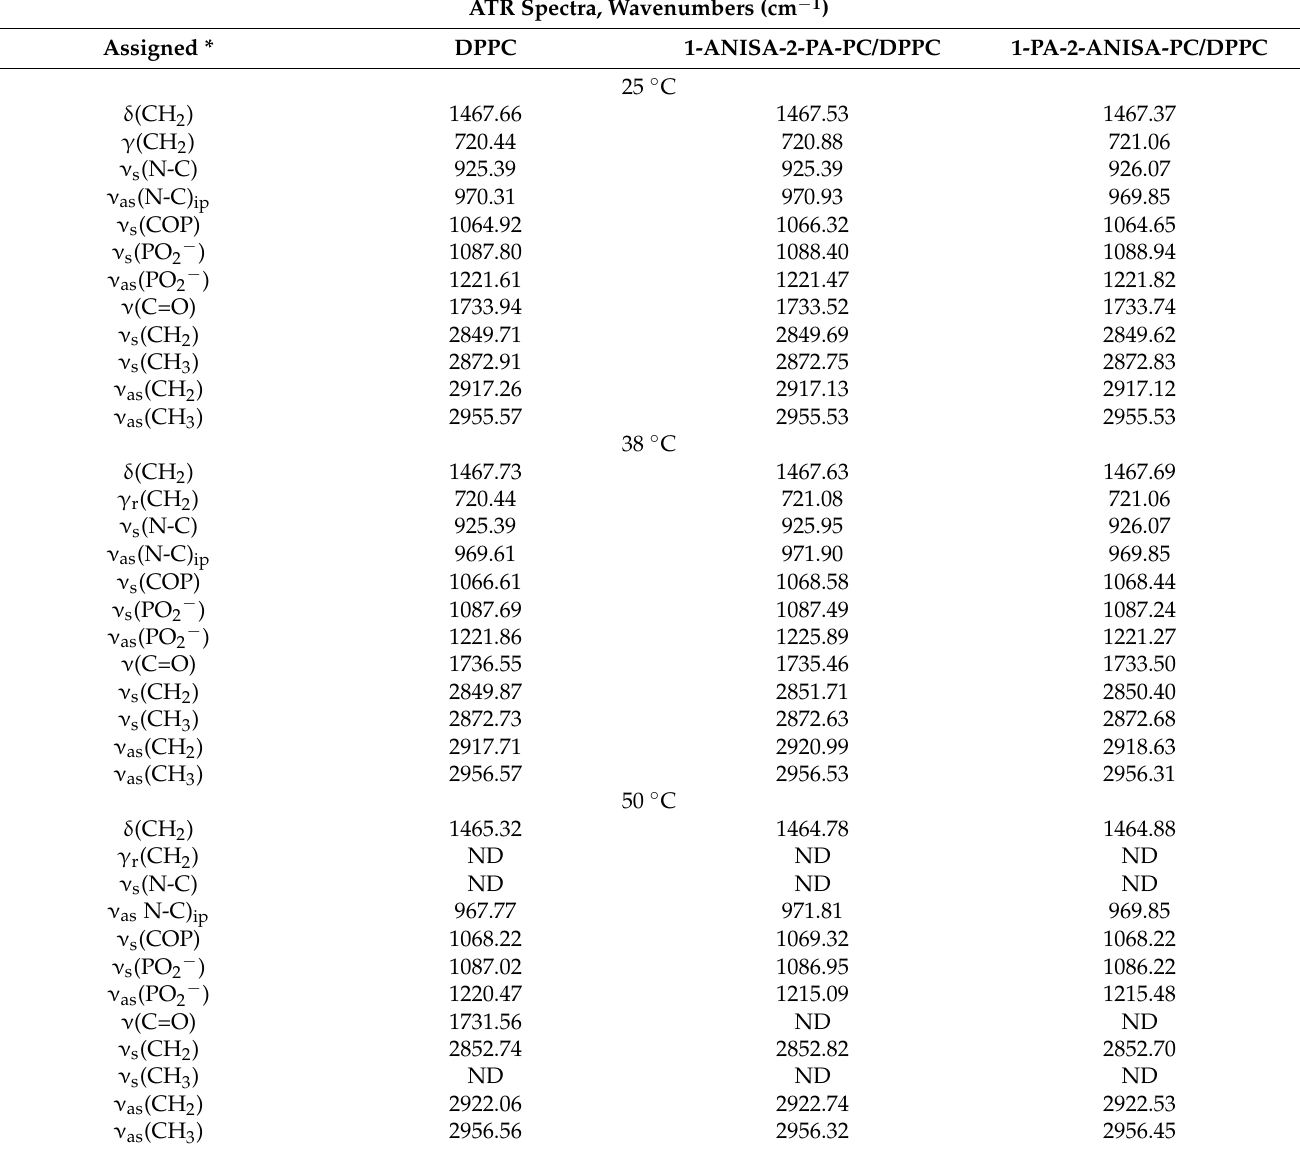
Table 1. Assigned bands of ATR-FTIR spectra of hydrated DPPC bilayer and of hydrated 1-ANISA-2-PA-PC/DPPC (1:5) and 1-PA-2-ANISA-PC/DPPC (1:5) bilayer at different temperatures. The conjugate:DPPC molar ratio was 1:5. ATR Spectra, Wavenumbers (cm − 1